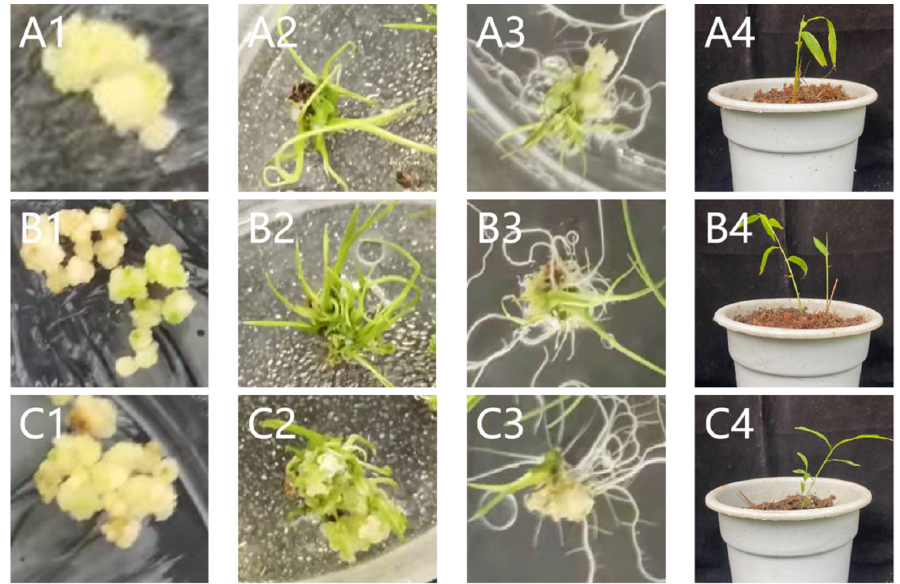
Figure 5. Genetic transformation of B. pervariabilis × D. grandis . ( A ): cof-RNAi; ( B ): cad-RNAi; ( C ): wild type B. pervariabilis × D. grandis ; 1 : callus, 2 : differentiation of buds, 3 : differentiation of rooting,